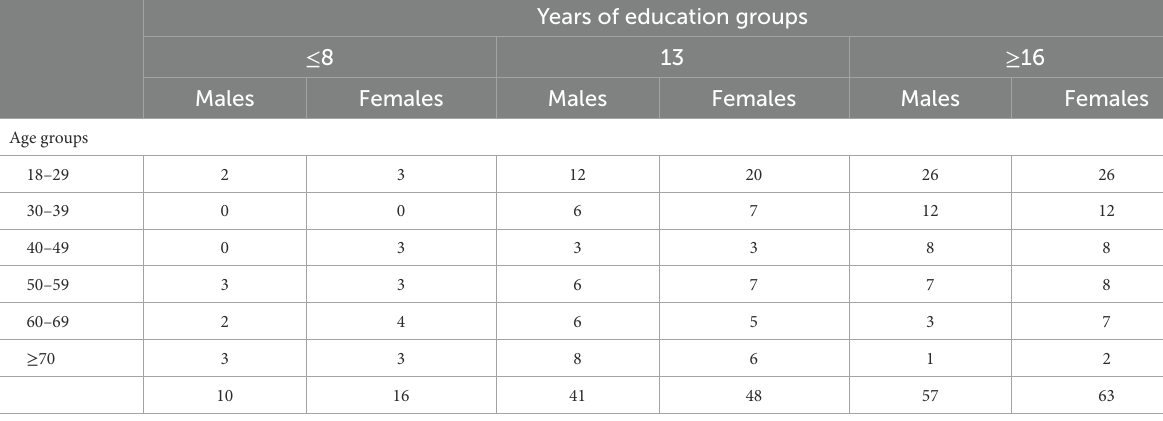
TABLE 2 Correlations between Yoni-48 scores and ET and GT. Yoni